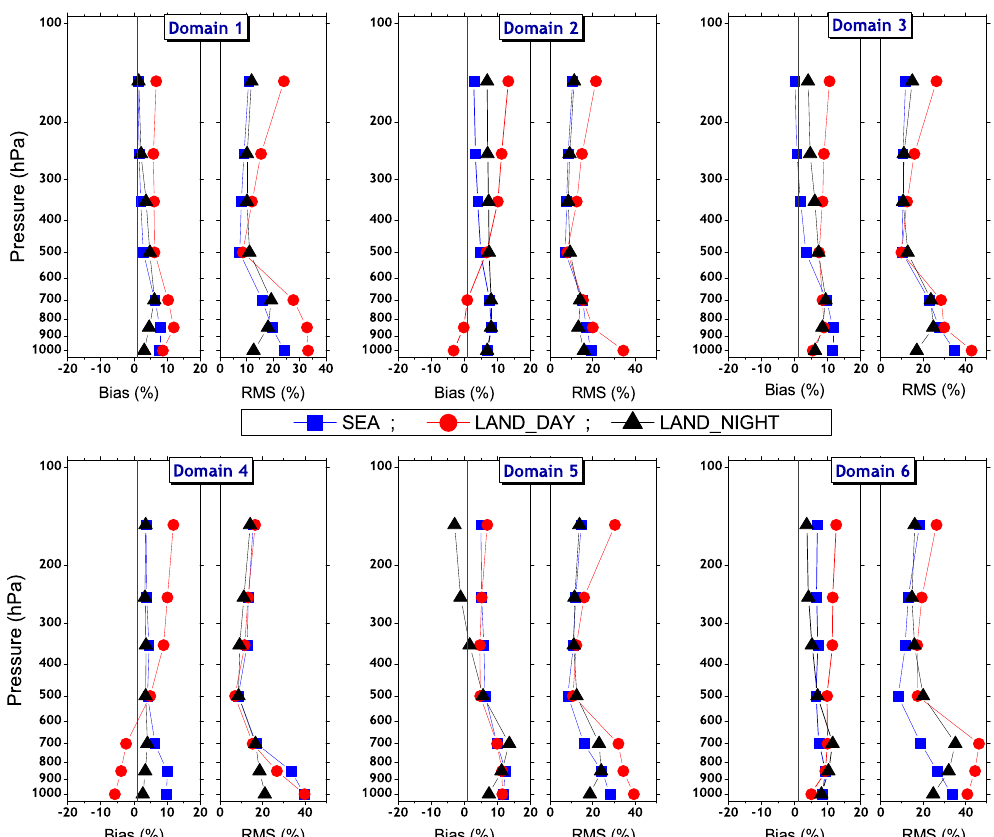
Figure 8. The mean bias and the corresponding RMS (root mean square) between CO vertical profiles deduced from the MOPITT V3 CO Fig. 8. The mean bias and the corresponding RMS (Root Mean Square) between CO vertical profiles deduced TOTCOL_ANALYSES and the MOPITT V3 observations. The comparison is made for observations carried out over land during daytime from the MOPITT V3 CO TOTCOL ANALYSES and the MOPITT V3 observations. The comparison is made (red), those carried out over land during night-time (black) and those carried out over sea for observations carried out over land during daytime (red), those carried out over land during nighttime (black) and those carried out over sea (blue).